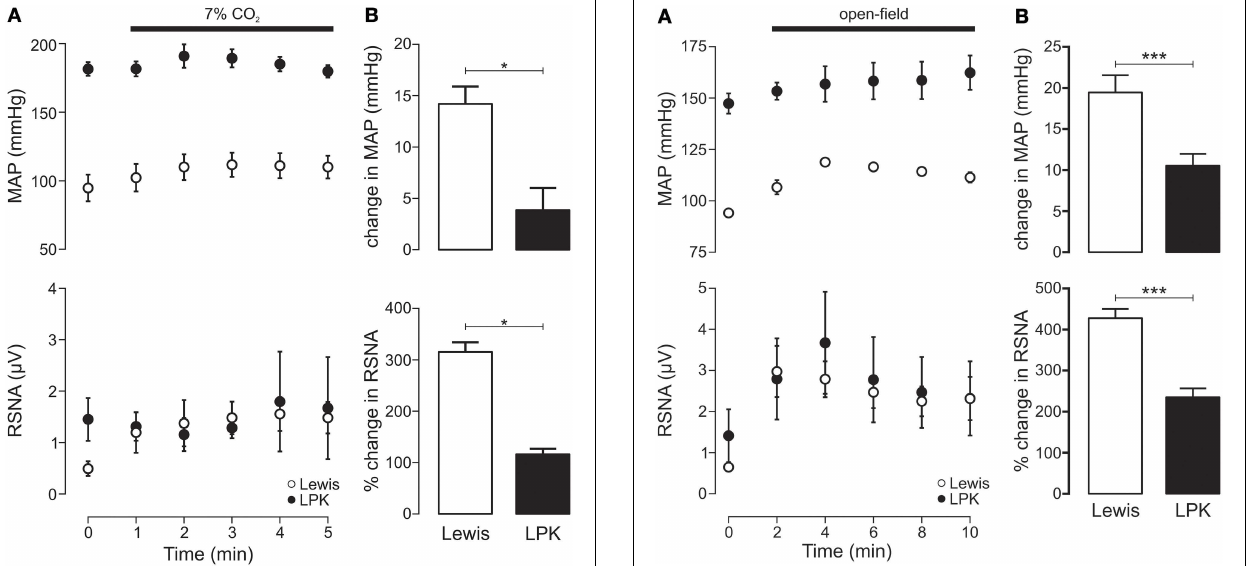
FIGURE 4 | Mean arterial pressure (MAP) and renal sympathetic nerve activity (RSNA) responses to central chemoreflex activation in Lewis and Lewis Polycystic Kidney (LPK) rats. (A) Data points are 1-min averages of RSNA and MAP measured for 1min before (time zero) and 5min during a hypercapnic challenge (7% CO 2 ). (B) average change in MAP and RSNA during the challenge. Results are expressed as mean ± SEM. * p < 0 . 05 . Minimum n /group = 4.